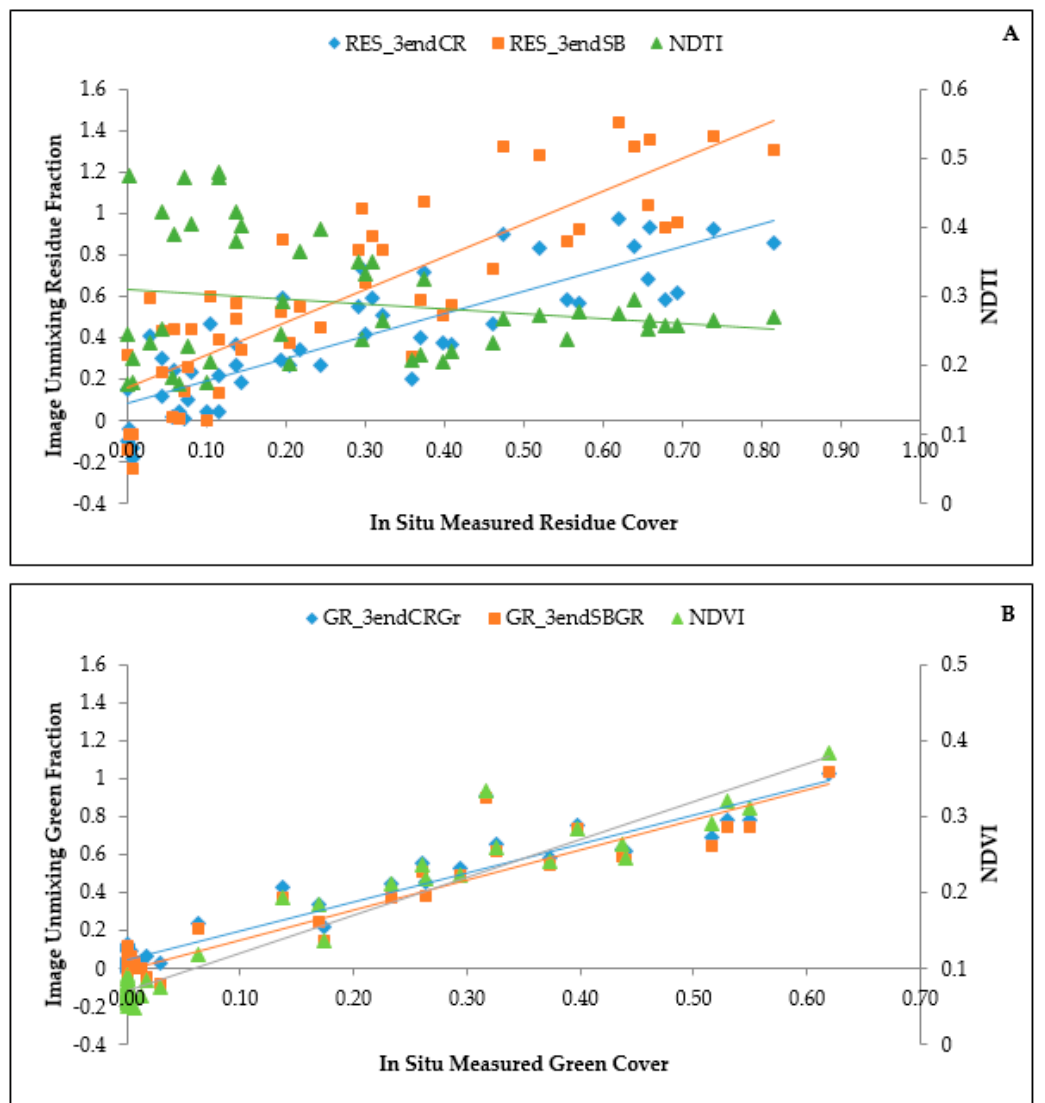
Figure 4. Unmixing fraction results using soybean or corn three end member combinations and index results for Image 18/30 2016-04-18 (n = 49). ( A ) Residue fraction and normalized difference tillage index (NDTI) compared to measured residue cover ( B ) Green fraction and Normalized Difference Vegetated Index (NDVI) compared to measured green cover.